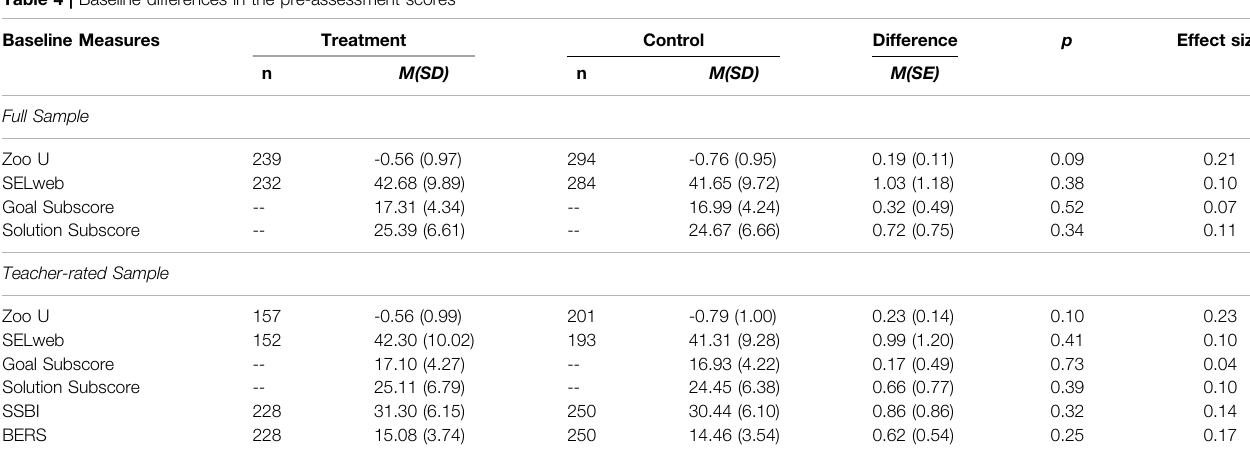
Table 4 | Baseline differences in the pre-assessment scores Baseline